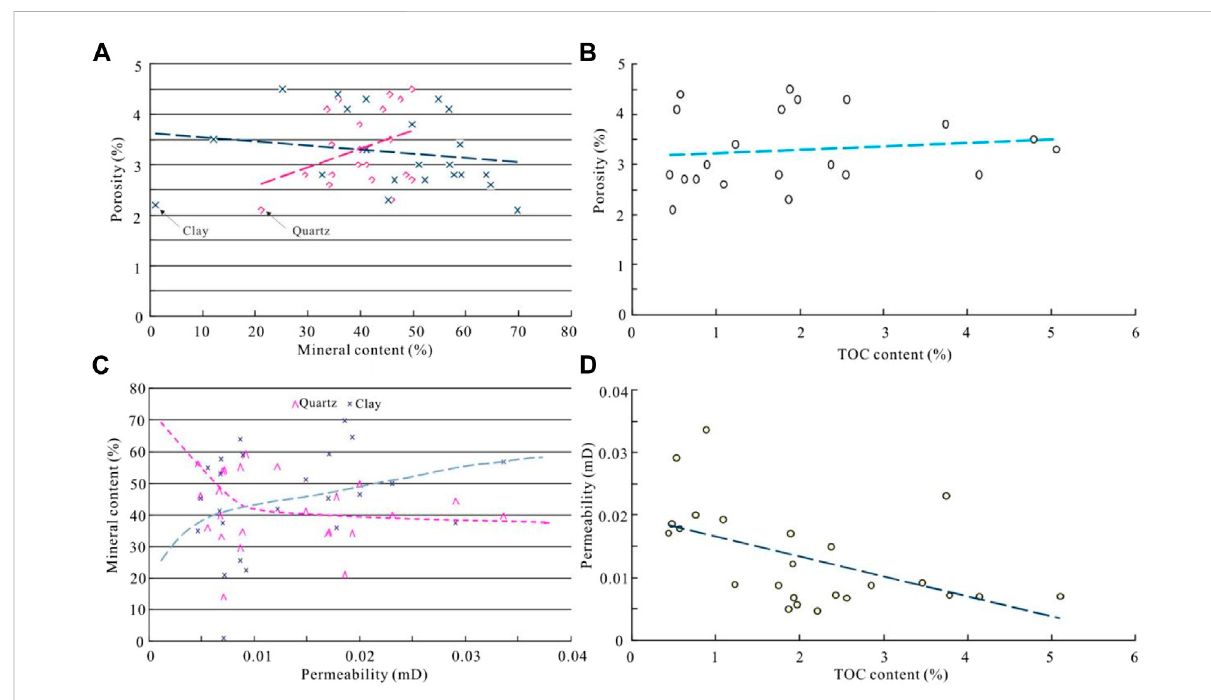
FIGURE 9 Characteristics of physical parameters, TOC content and mineral composition content of shale samples in the target layer. (A) Relationship between mineral composition content and porosity; (B) Relationship between TOC content and porosity; (C) Relationship between mineral composition content and permeability; (D) Relationship between TOC content and